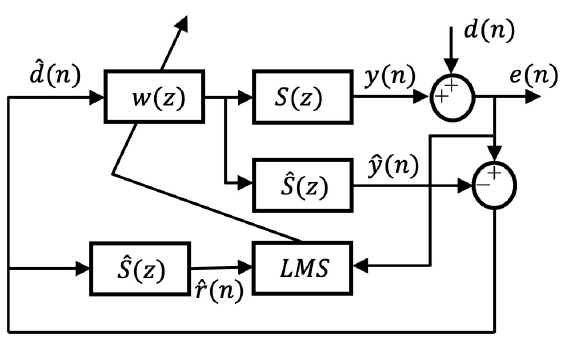
Figure 6. Block diagram of adaptive feedback